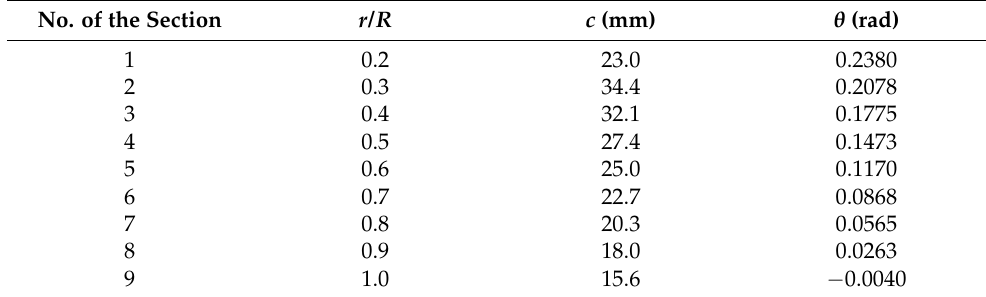
Table 1. Model turbine specifications.